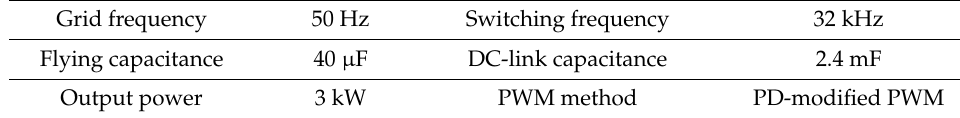
Table 6. Specifications and conditions of the experiment.